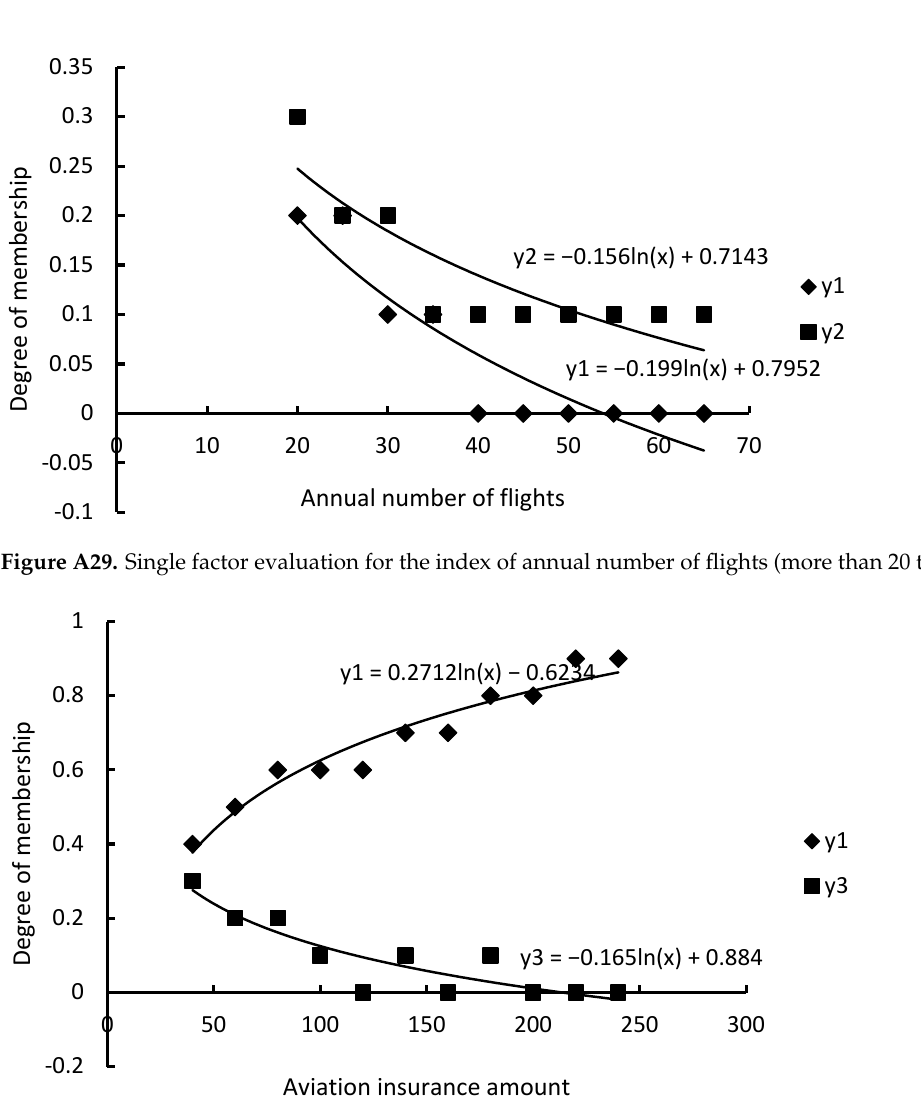
y2 = 0.3297x + 0.1593